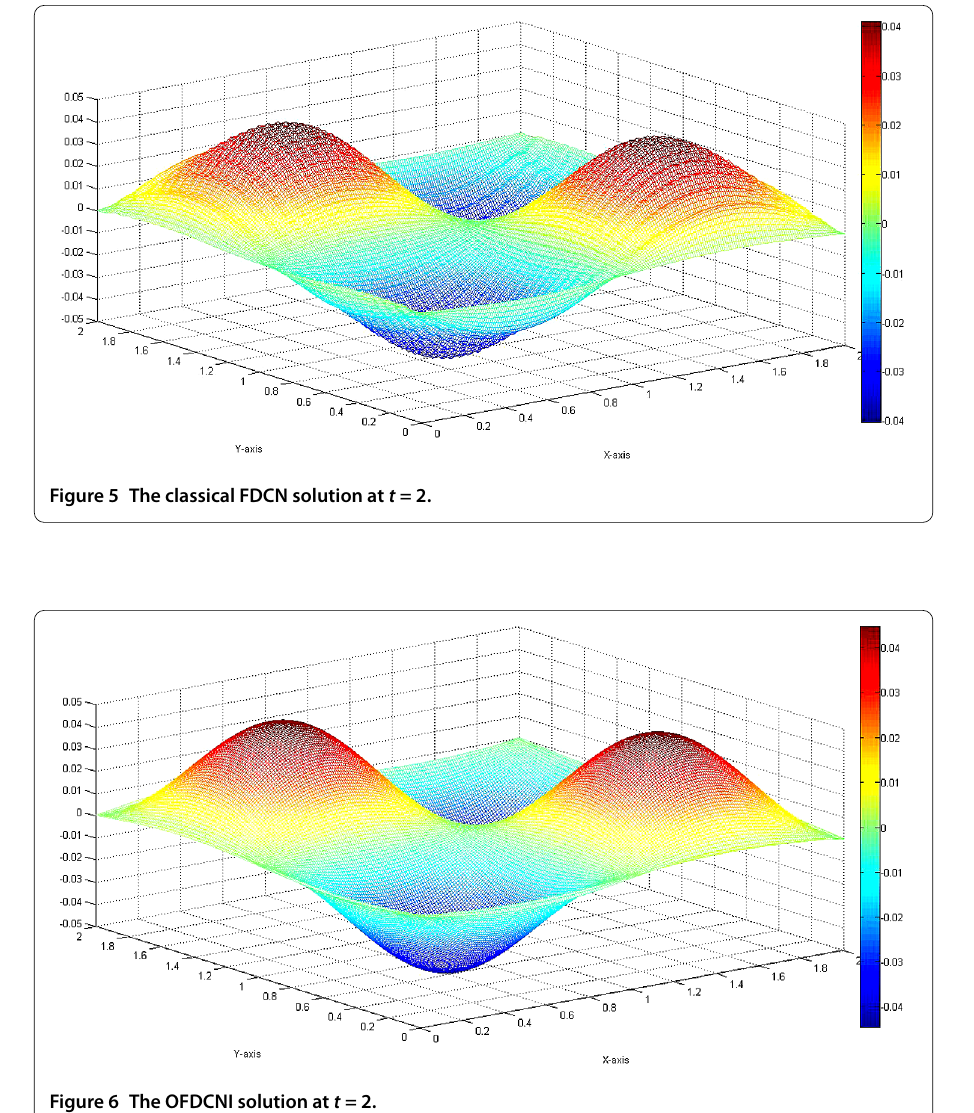
Figure 6 The OFDCNI solution at t =